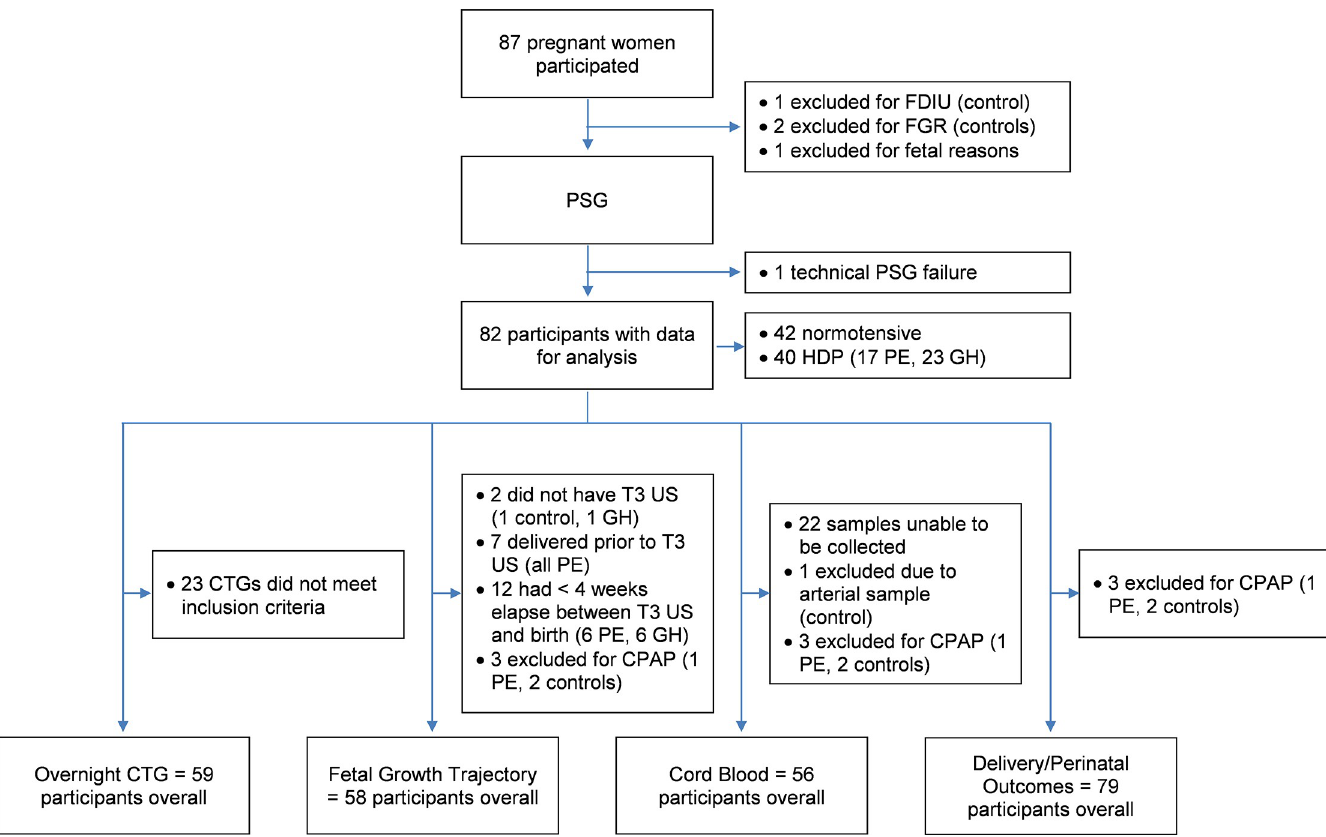
Fig 1. Flow chart of participant data available for each fetal outcome. FDIU = fetal death in utero, FGR = fetal growth restriction, GH = gestational hypertension, PSG = polysomnography, CTG = cardiotocography, T3 = third trimester, US = ultrasound, PE = preeclampsia, CPAP = continuous positive airway pressure.